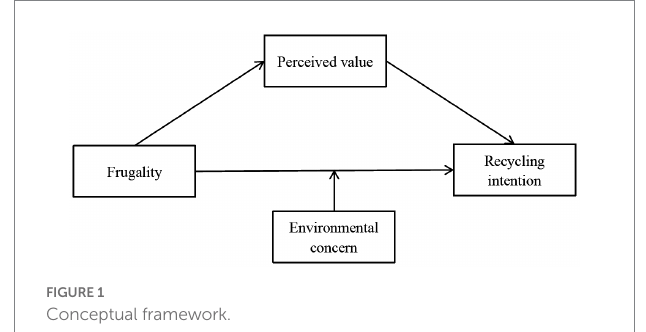
FIGURE 1 Conceptual framework.